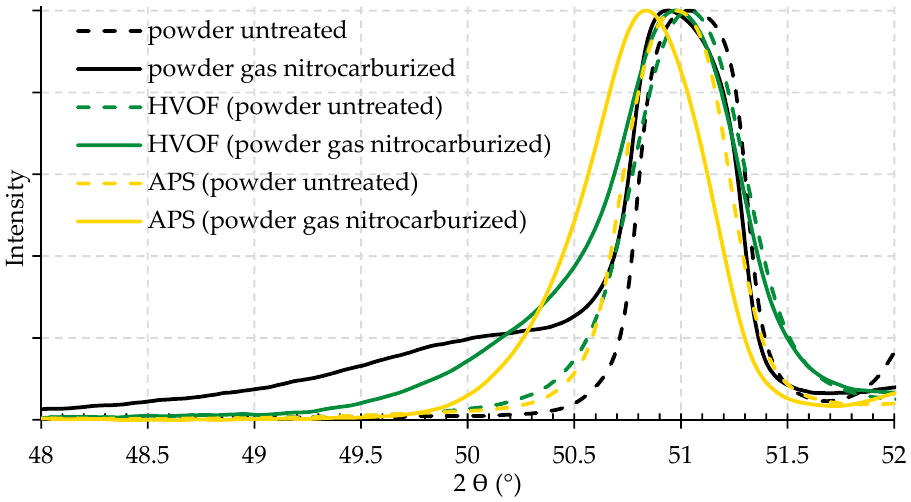
Figure 5. Sections of diffraction diagrams of the untreated and gas nitrocarburized AISI 316L powders and the HVOF and APS coatings.